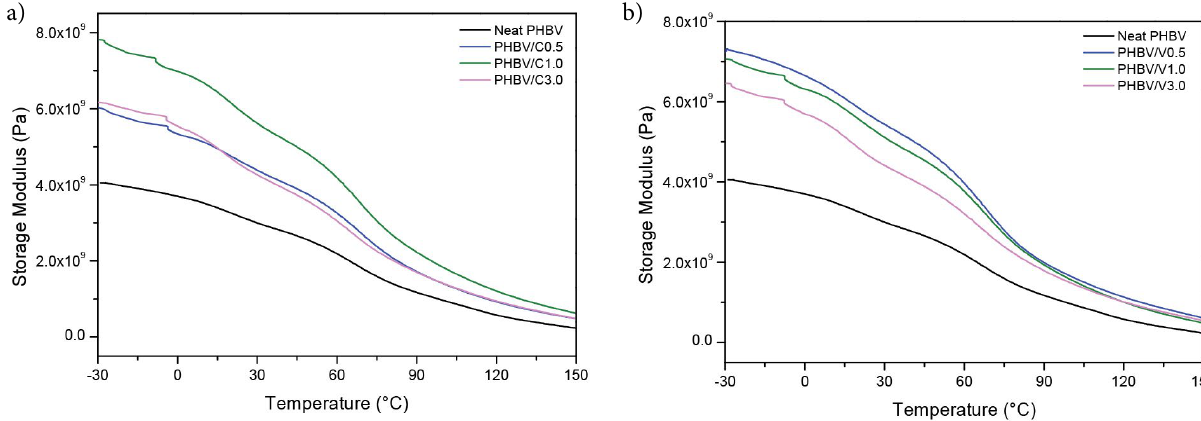
Figure 10. DMA thermographs showing storage modulus for PHBV/CaCO 3 composites with (a) calcite and (b)